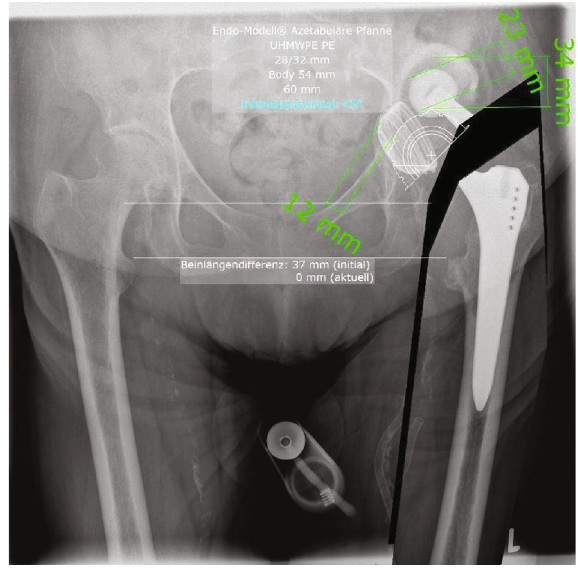
Figure 3: Preoperative planning using cemented Mark III cup.